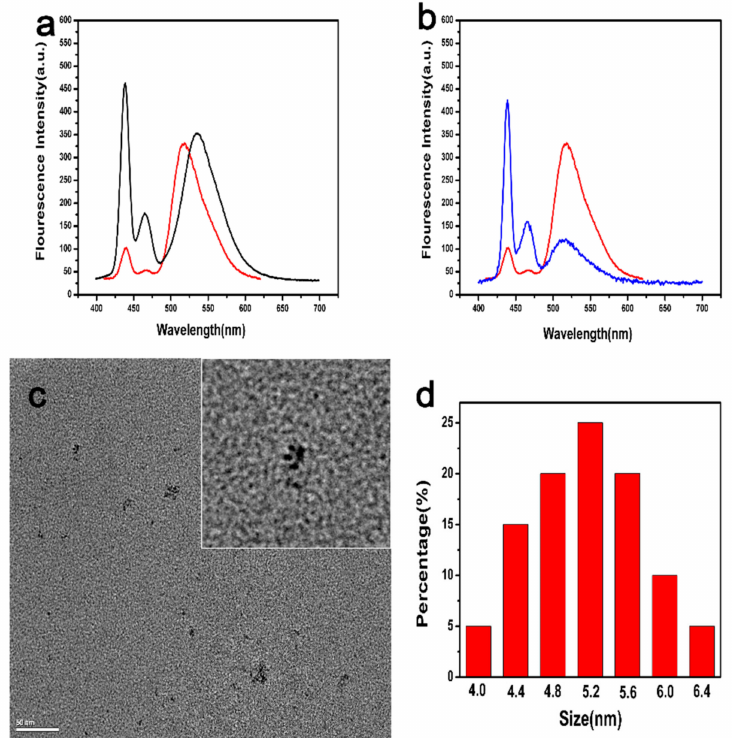
Figure 3. ( a ) Fluorescence spectra of Pdots-PP (black solid line) and Pdots-PPF (red solid line) when excited at 380 nm. ( b ) Fluorescence spectra of Pdots-PF (blue solid line) and Pdots-PPF (red solid line) when excited at 380 nm. ( c ) TEM of Pdots-PPF. Scale bar represents 50 nm. The inset shows the